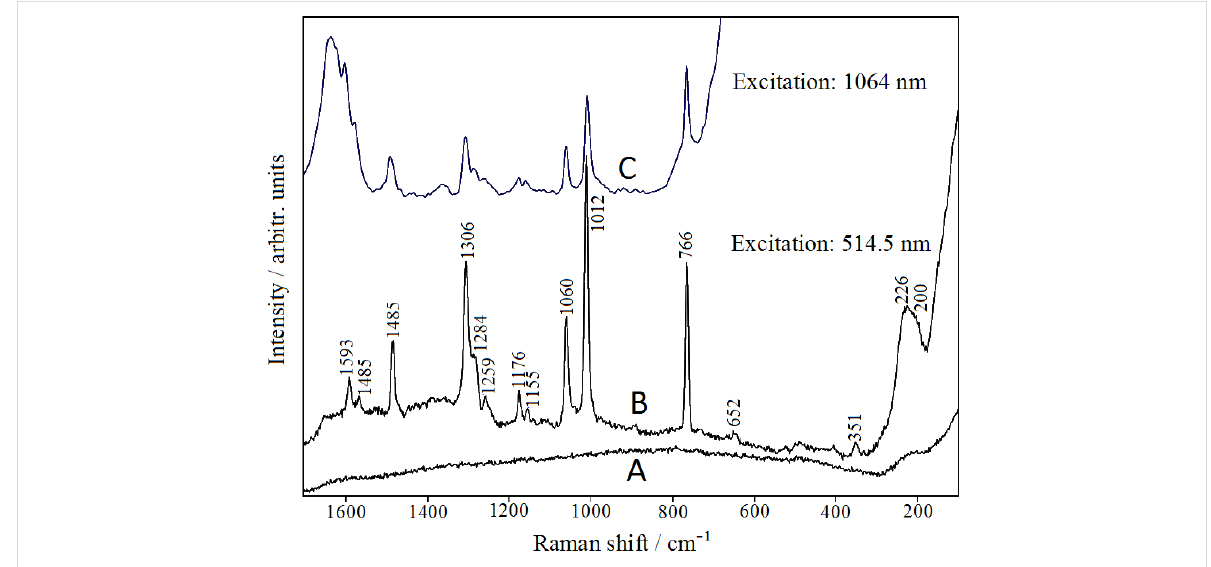
Figure 3: SERS spectra of bpy in Ag-doped silica colloid by excitation with the 514 nm (B) and 1064 nm (C) laser lines. The Raman spectrum of silica (514 nm) is also reported (A).